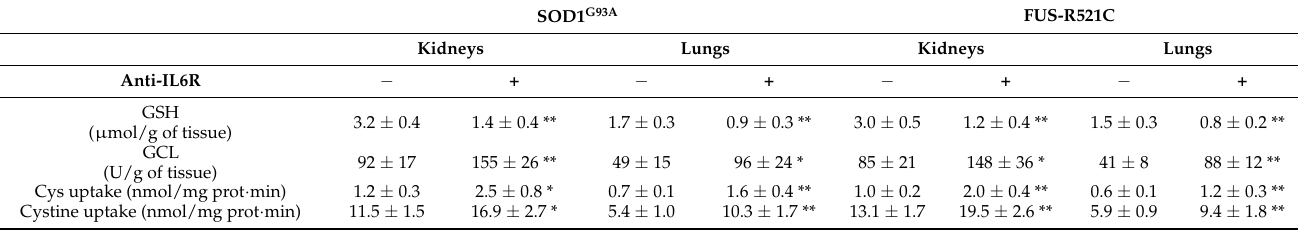
Table 4. Effect of in vivo treatment with anti-IL6 mAbs on GSH levels, GCL activity and Cys/cystine uptake in kidneys and lungs of the ALS mouse models. Antibodies were administered, as described in Methods, during the seven days prior to assay of all parameters. Rates of Cys and cystine were calculated after administering i.v. 2.0 µ Ci of [ 35 S]Cys or 10.0 µ Ci of [ 35 S]cystine (PerkinElmer, Waltham, MA, USA). Data are mean values ± SD for n = 5–6. * p < 0.05, ** p < 0.01 comparing data for each parameter obtained in anti-IL6R-treated mice versus controls treated with physiological